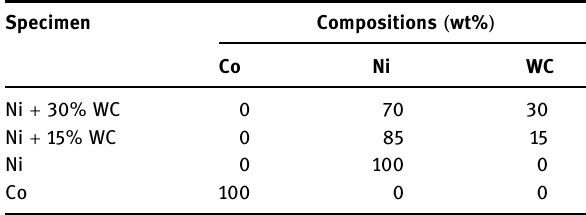
Table 4: Compositions of the studied coatings